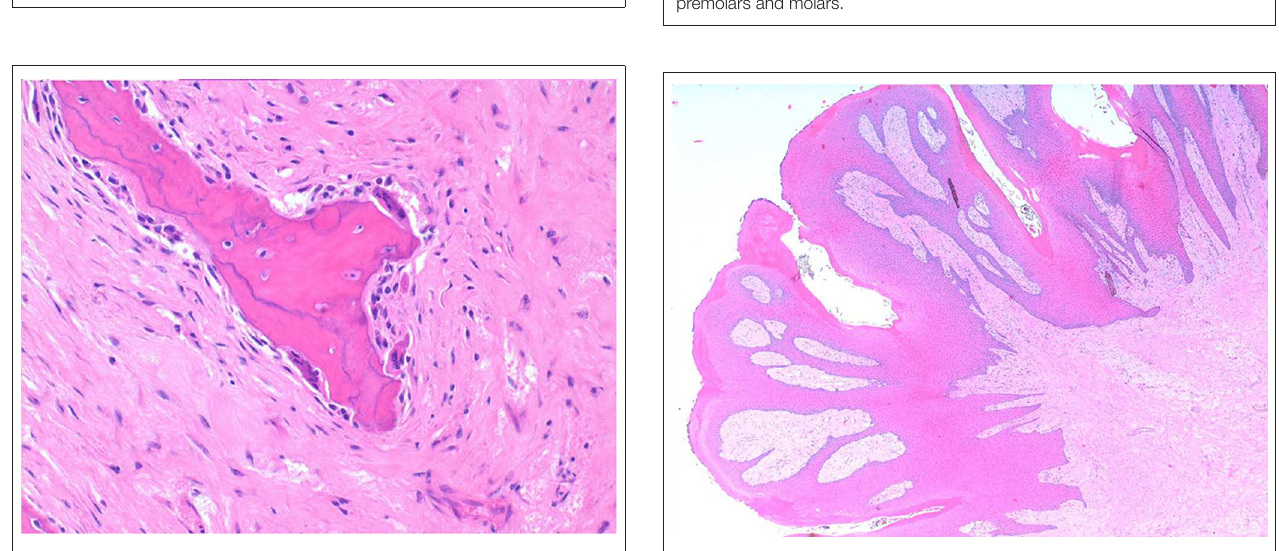
FIGURE 8 | Mandibular mass, roe deer; spicules are lined by osteoblasts and those larger and deeper seated in the mass undergo bone remodeling at their surfaces; H&E stain.